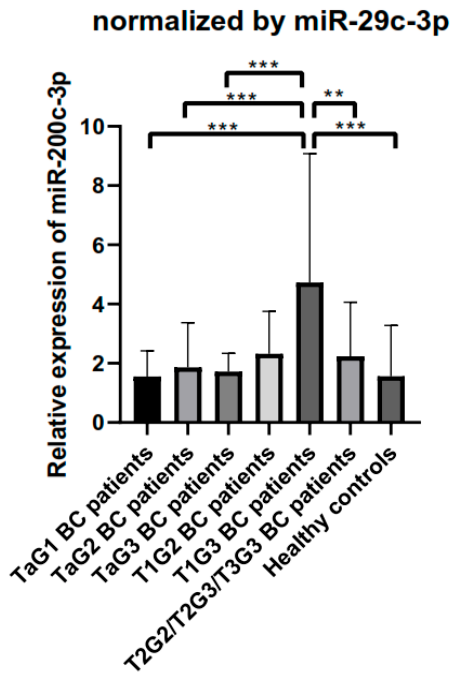
Figure 7. Relative expression of miR-200c-3p normalized by miR-29c-3p in the validation cohort. Normalization was performed by the 2 − ∆∆ Ct method. Error bars represent the standard error of the mean. ANOVA with the Tuckey Post Hoc test: ** p < 0.01; *** p < 0.001.